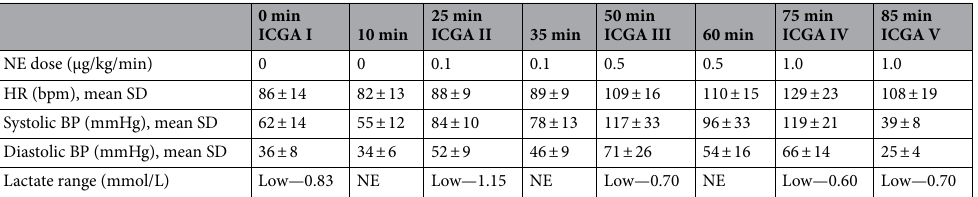
Table 2. Mean measurements over time. ICGA indocyanine green angiography (I = baseline, II = after norepinephrine (NE) dose 1, III = after NE dose 2, IV = after NE dose 3, V = remnant measurement following discontinuation of NE), HR heart rate, BP blood pressure, bpm beats per minute .